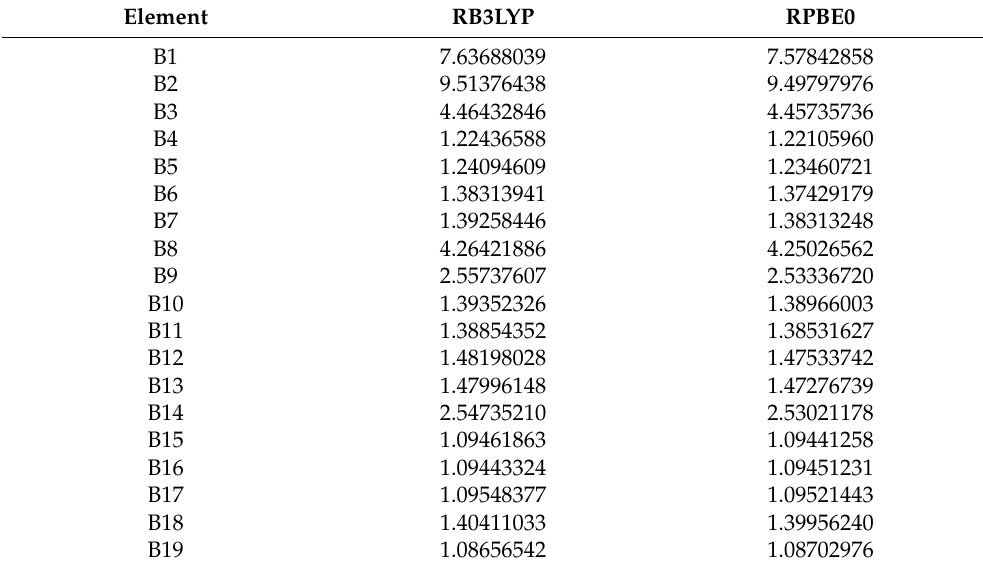
Table A2. Elements of the Z − matrix of ATV in methanol optimized as indicated below using 6-31+G/d,p) basis